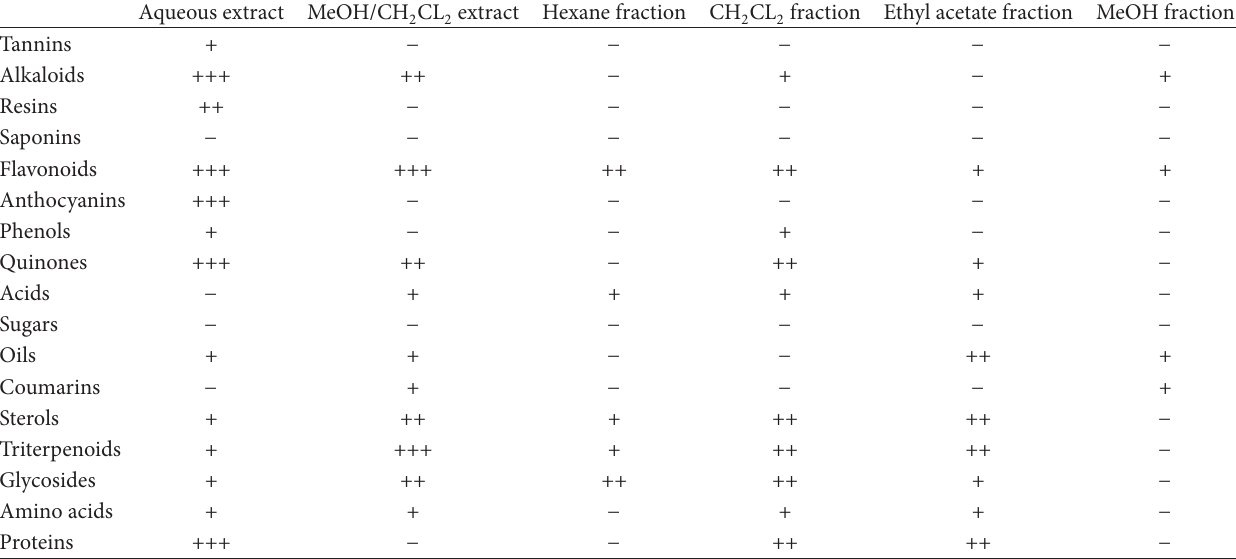
Table 1: Preliminary phytochemical analysis of the aqueous and MeOH/CH methanol fractions of E. speciosa